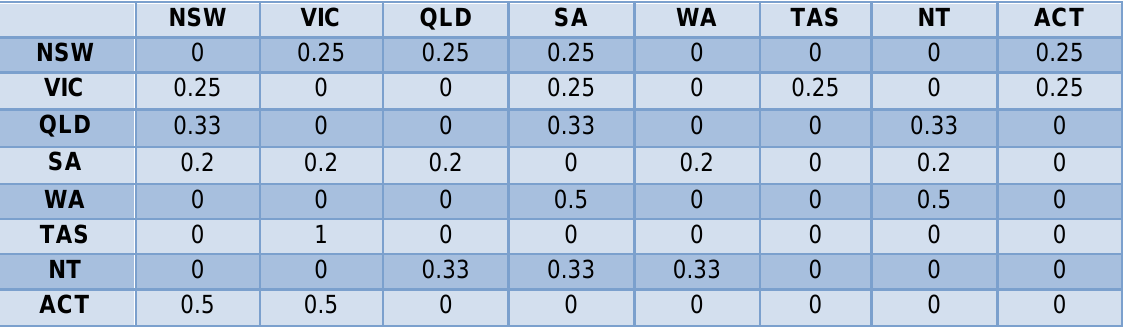
Table 1 The spatial weight matrix of Australian regional construction